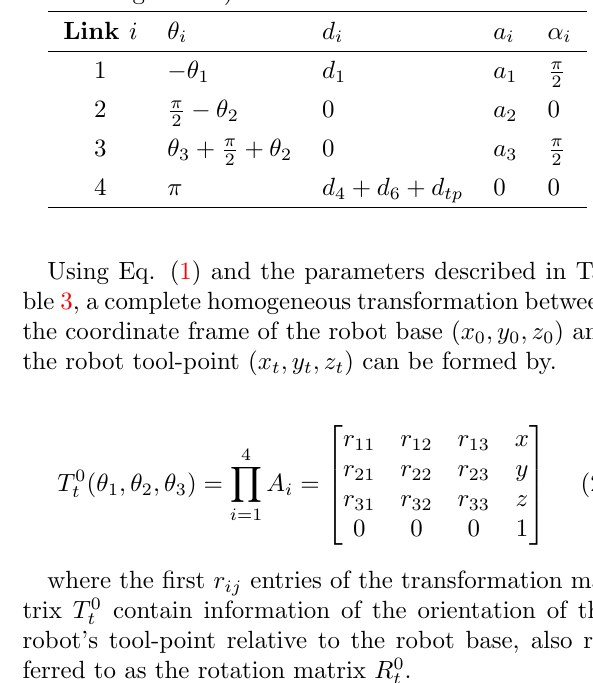
Table 3: DH table for the Comau Robot (3-DOF con- figuration) with the extension